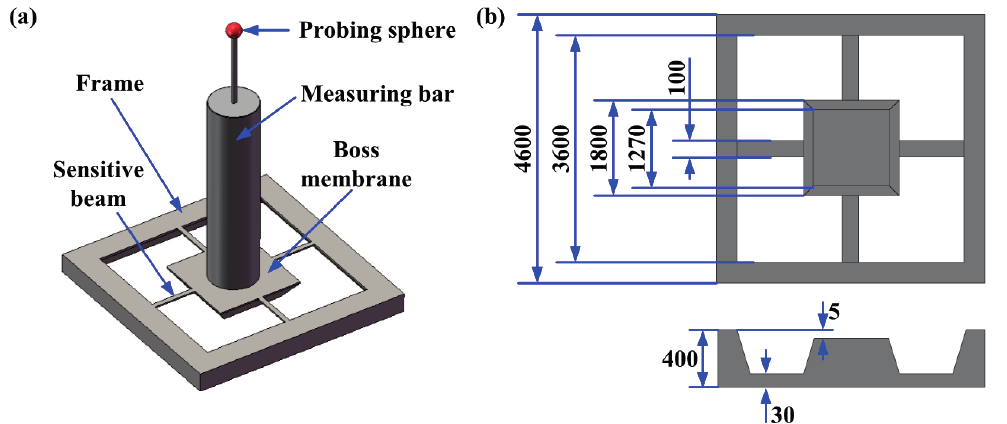
Figure 1. Mechanical structure. ( a ) Mechanical structure; ( b ) Detailed size / μ